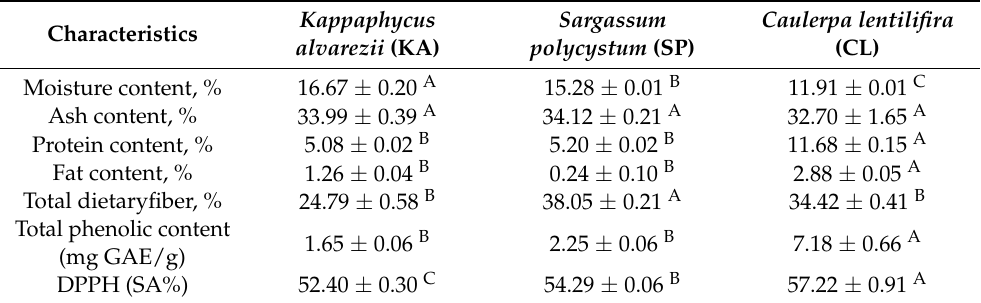
Table 1. Chemical composition and phenolic content of Kappaphycus alvarezii (KA), Sargassum polycys- tum (SP), and Caulerpa lentilifira (CL) seaweed.